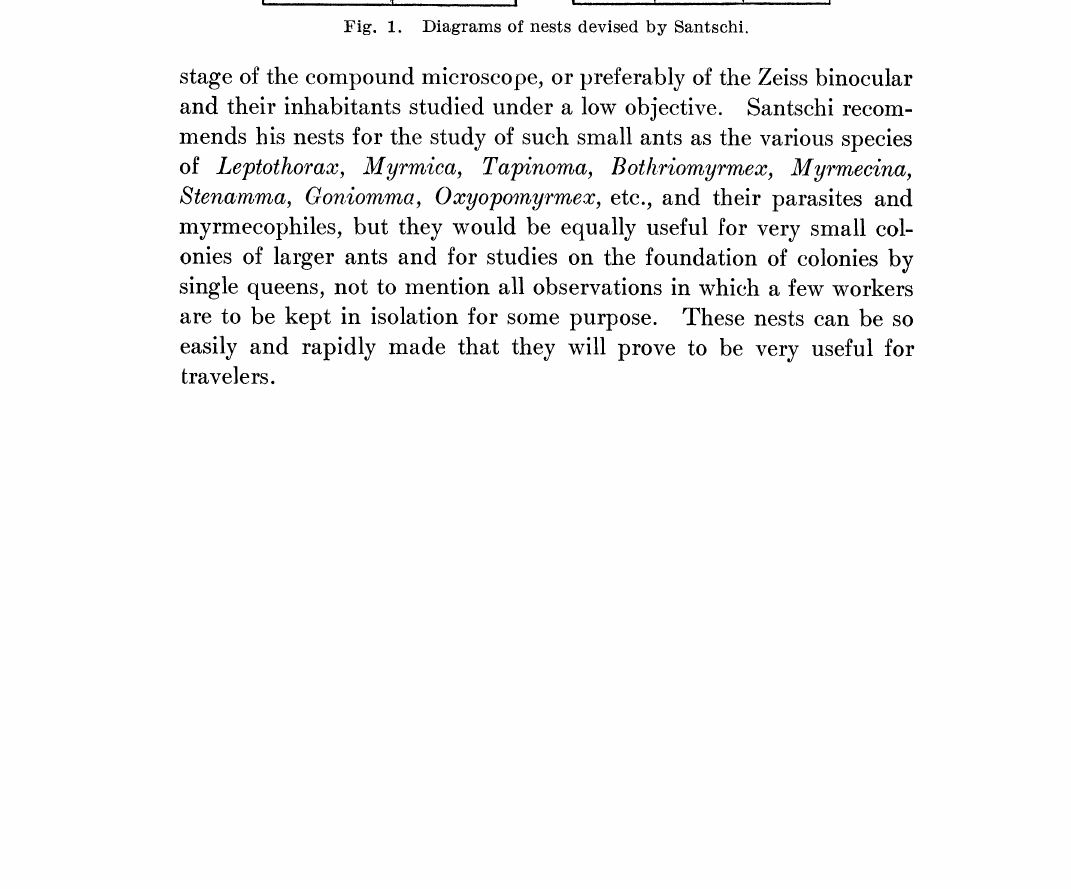
Fig. 1. Diagrams of nests devised by